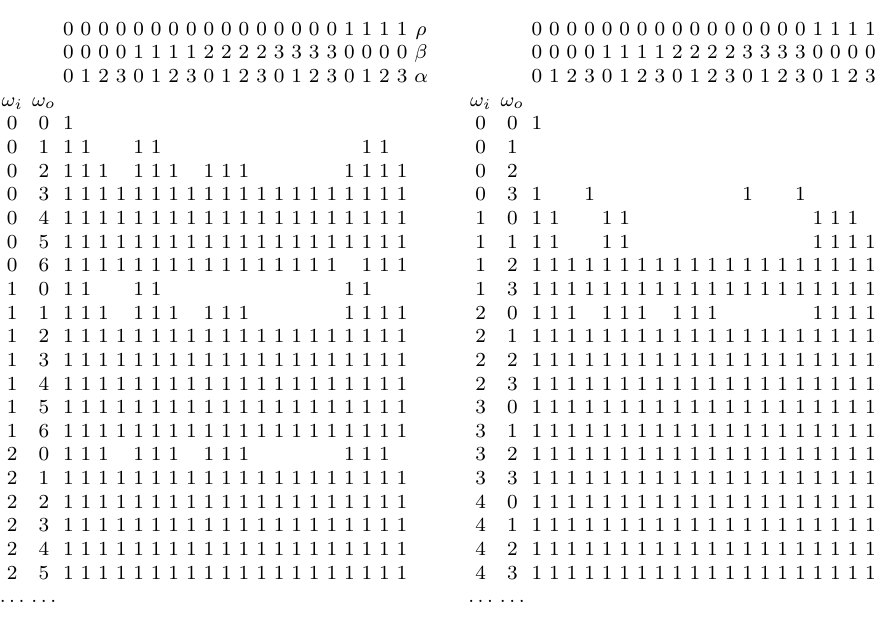
Figure 18: Part of the vulnerability profiles of DOM without (left) and with (right) output register for d = 2 ( s =